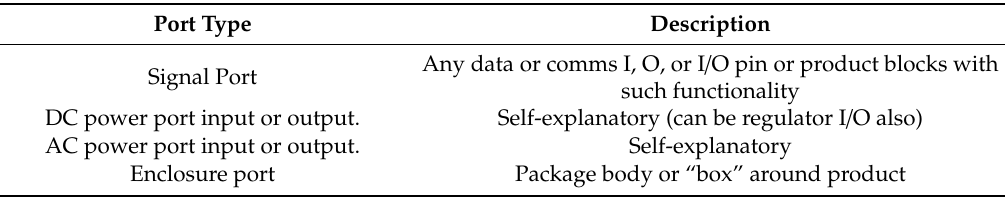
Table 1. IEC 61000-6-2 system port definitions.